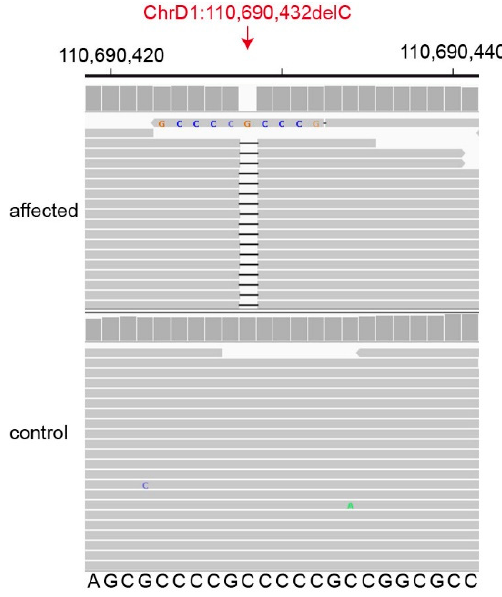
Figure 4. Details of the LTBP3 :c.158delG, p.(Gly53Alafs*16) variant. Integrative Genomics Viewer (IGV) screenshot showing the short-read alignments of the affected kitten and a control cat at the position of the deletion, which affects the coding part of the first exon. Note that in the IGV screenshot, base 110,690,428 is deleted, which represents the first possible position of the deletion. Taking into consideration the 3 ′ -rule of HGVS nomenclature, the correct variant designation is ChrD1:110,690,432delC (Felis_catus_9.0